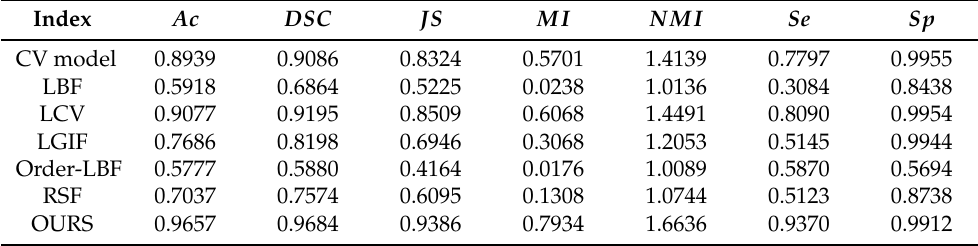
Table 1. Evaluation index of short-circuit line feature extraction based on different segmentation